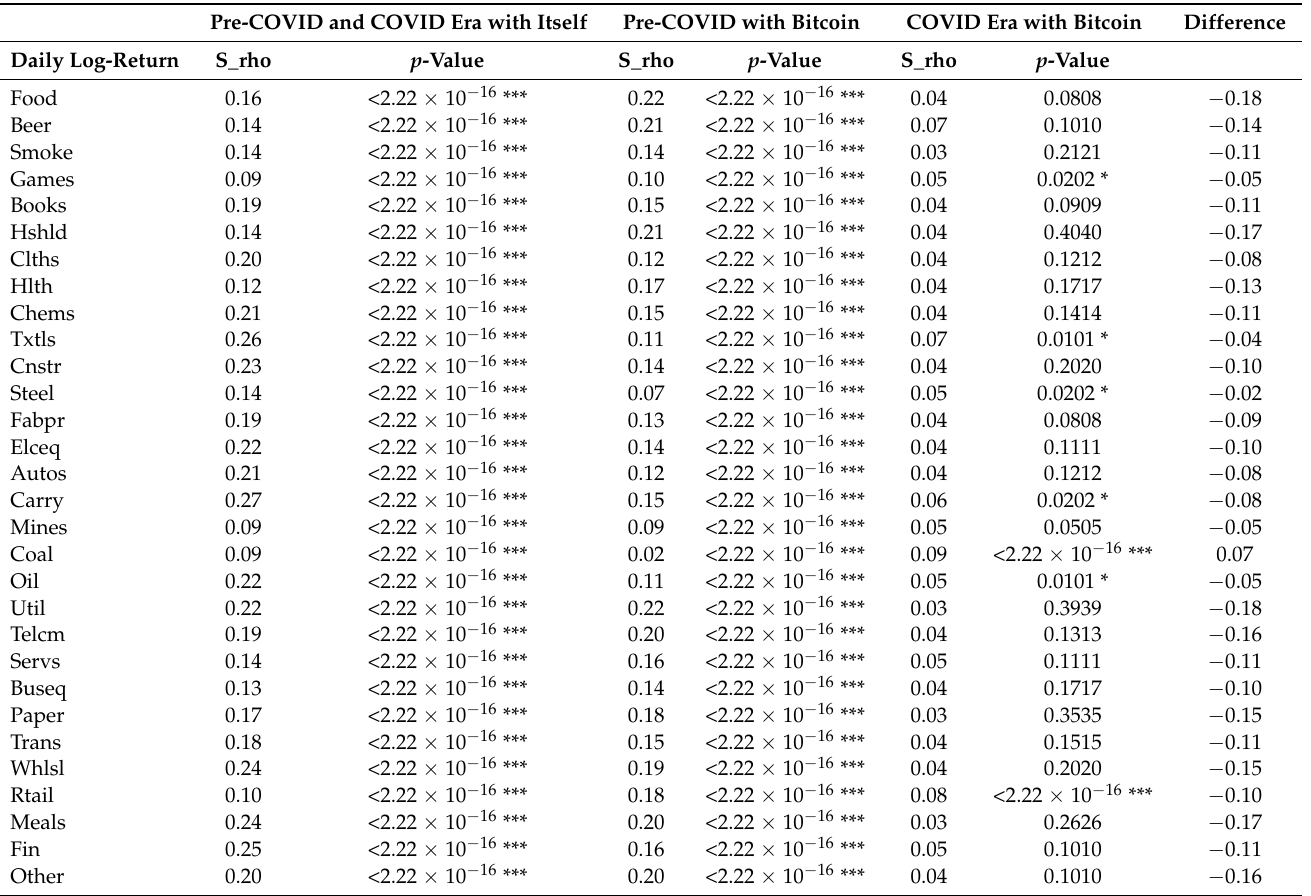
Table 4. Entropy measure between Bitcoin and different